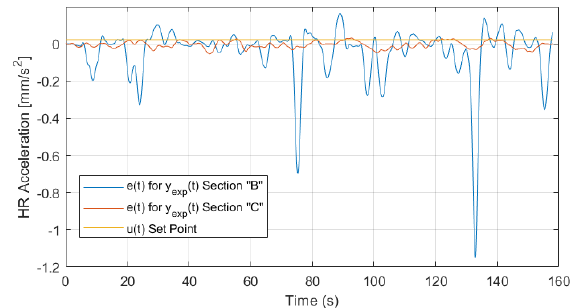
Figure 15. Error plot over time for y exp